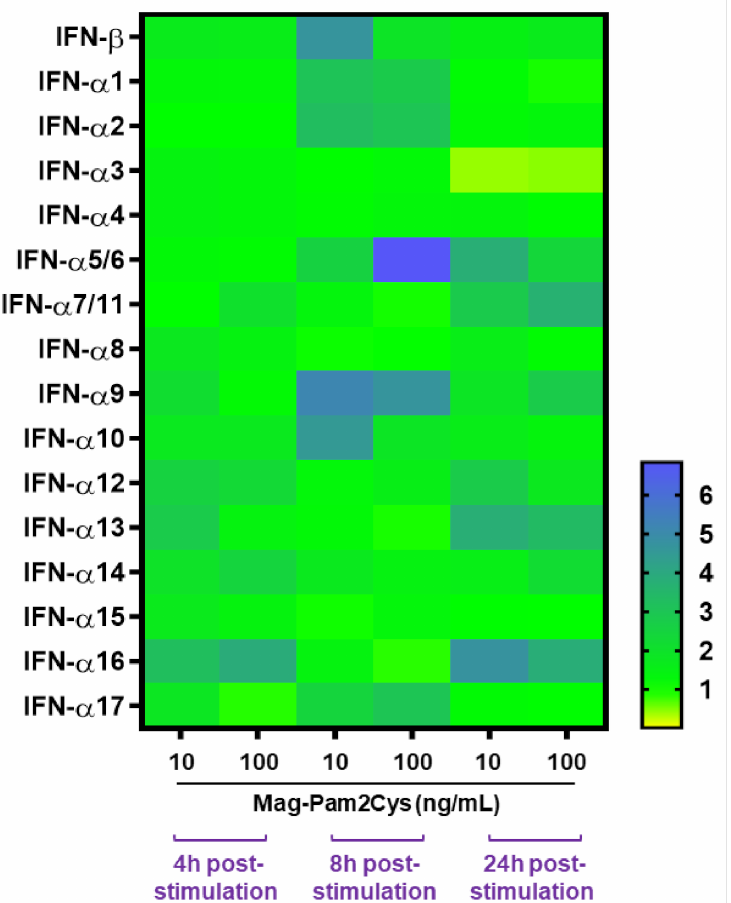
Figure 7. Heatmap of several type I IFNs genes differentially expressed in moM Φ . Porcine moM Φ were left untreated or stimulated with scalar doses of Mag-Pam2Cys (10 or 100 ng/mL). At 4, 8, and 24 h post-stimulation, gene expression levels of IFN- β and several IFN- α subtypes (- α 1, - α 2, - α 3, - α 4, - α 5/6, - α 7/11, - α 8, - α 9, - α 10, - α 11, - α 12, - α 13, - α 14, - α 15, - α 16, - α 17) genes were determined using qPCR. At each time point, data were normalized on the values of untreated control and expressed as 2 − ∆∆ Ct , with ∆ Cq = Cq (target gene)—Cq (reference gene), and ∆∆ Cq = ∆ Cq (Mag-Pam2Cys- stimulated samples)— ∆ Cq (untreated sample, moM Φ ). Mean data from six independent experiments using different blood donor pigs are shown. The colors in the cells represent the relative magnitude of gene expression. The green color represents the average magnitude of gene expression. The yellow color represents the smallest value, and the brightest blue represents the highest